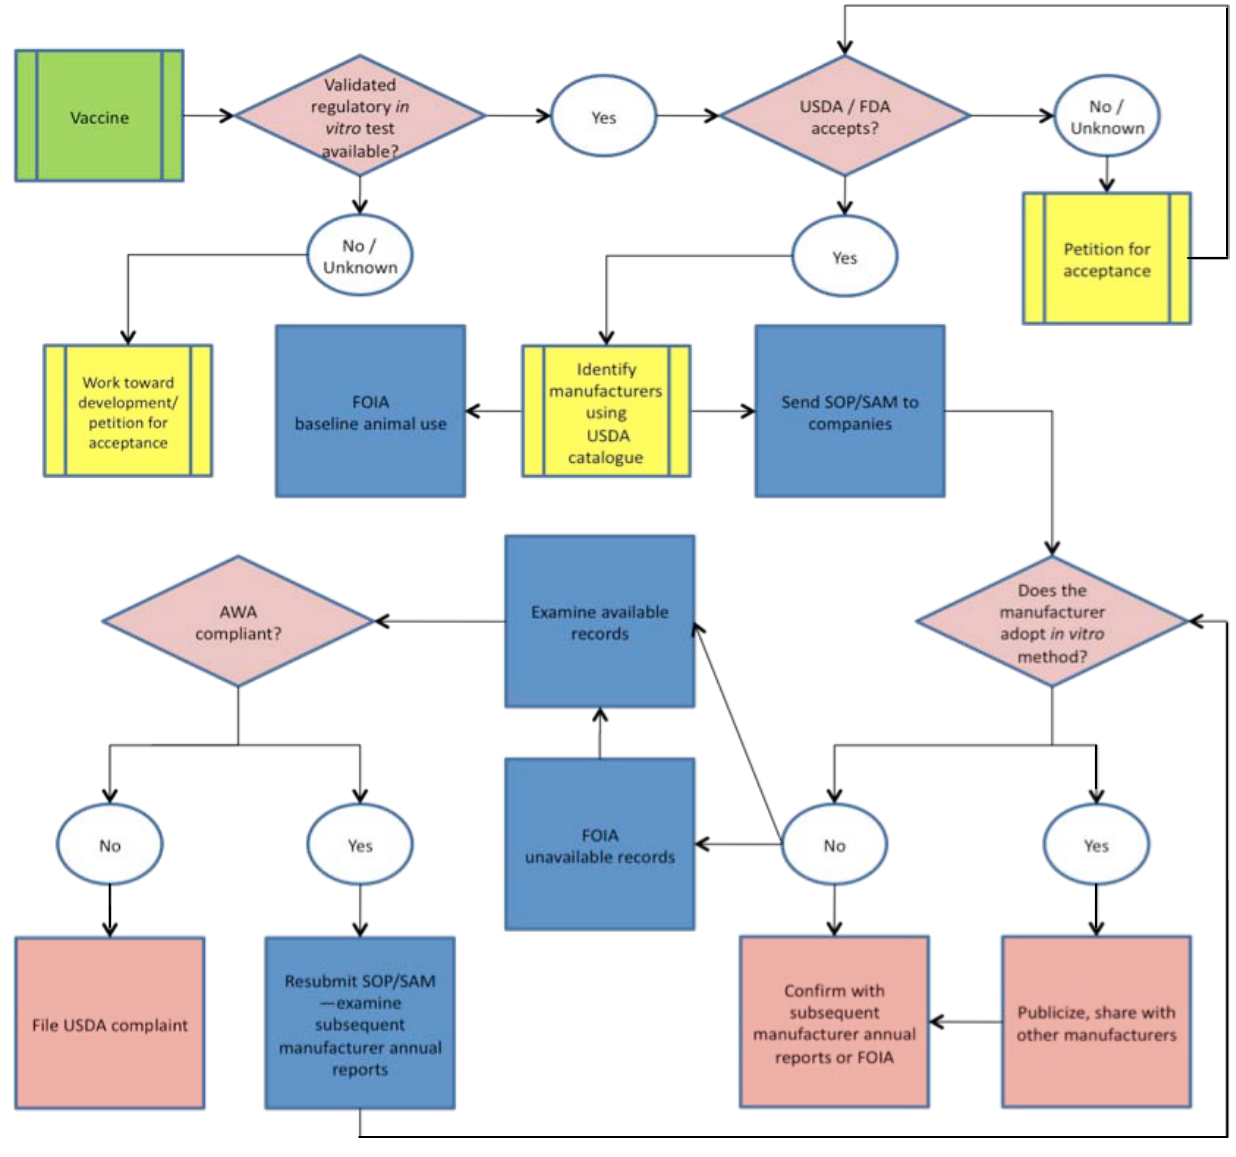
Figure 1. Generalized bridging paradigm for information-gathering and